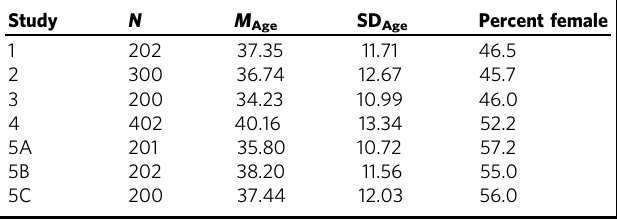
Table 1 Demographics across studies.